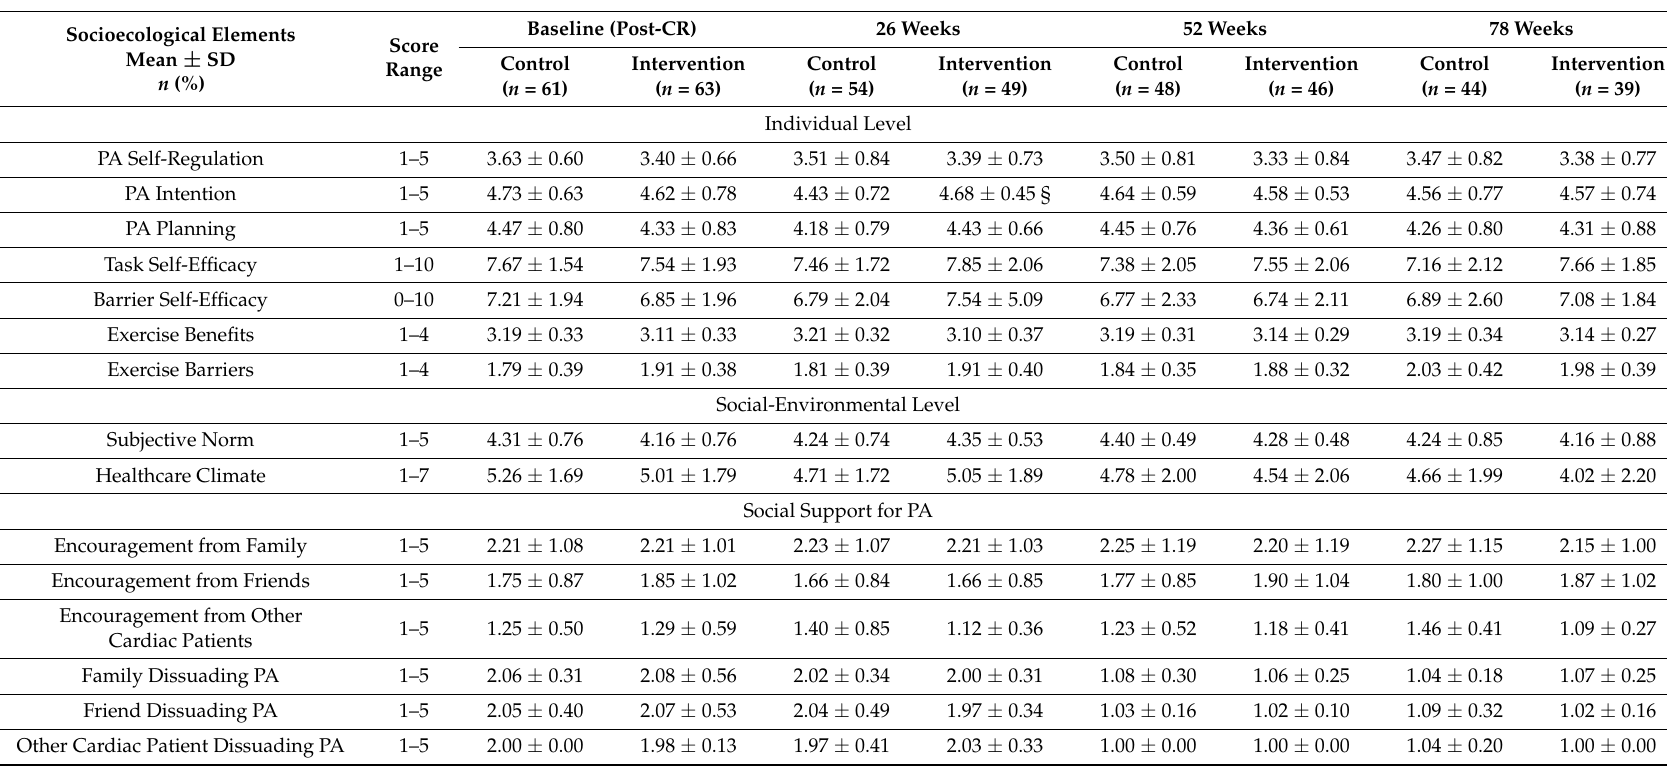
Table 2. Socioecological Elements, by Level and Study Arm through 1.5 Years Following Cardiac Rehabilitation Completion in Women Adherent to the Intervention. Socioecological Elements Mean ±